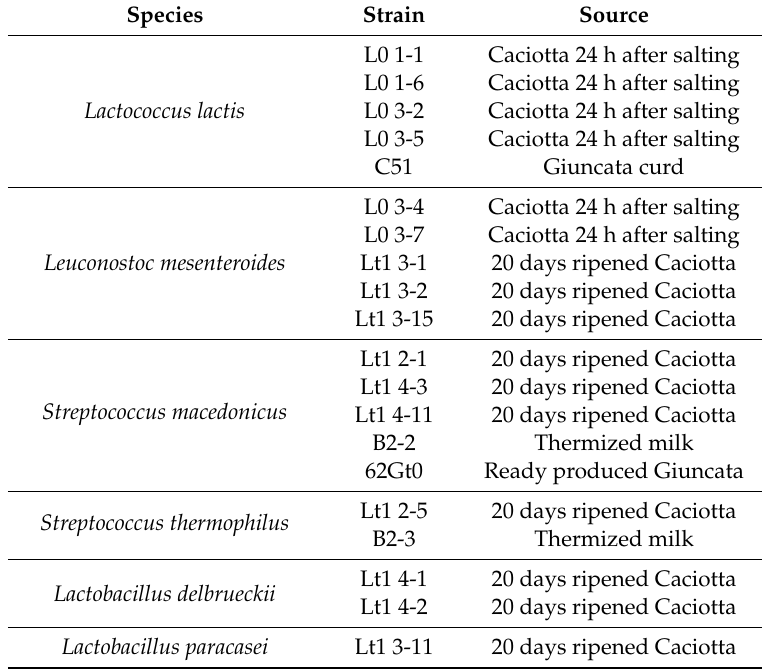
Table 2. Autochthonous lactic acid bacteria selected for further technological